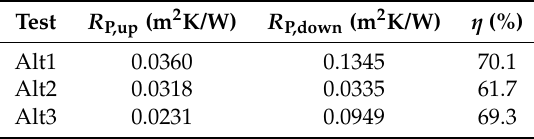
Table 4. Calculation results of the upward and downward thermal resistance of the sample panel and of their